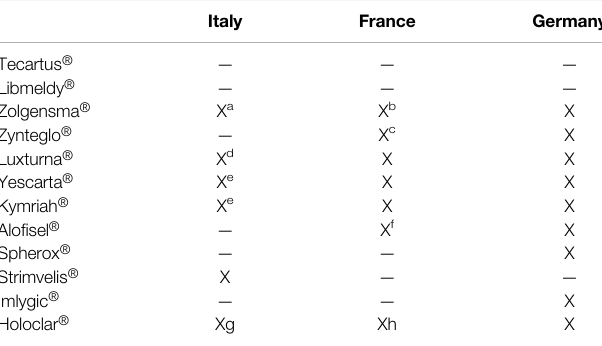
TABLE 3 | Reimbursement status in France, Germany, and Italy of ATMPs approved by the EMA. X (cid:1) reimbursed; / (cid:1) not reimbursed or fi nal opinion not available.